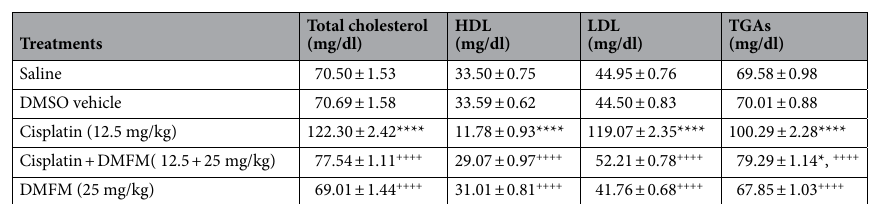
Table 2. Effect of DMFM treatment on lipid profile. Data are mean ± SEM, ( n = 7). *, **** p < 0.05 and P < 0.0001 versus Control respectively, and ++++ P < 0.0001 versus CP. Data analyzed by One-way ANOVA followed by Tukey’s multiple comparison